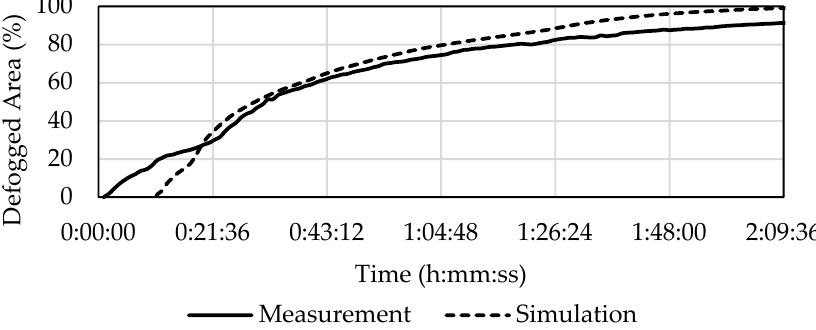
Figure 11. Development of defogging in C1.5 according to the experiment and the simulation. Table 8. Time comparison of defogging duration in C1.5.